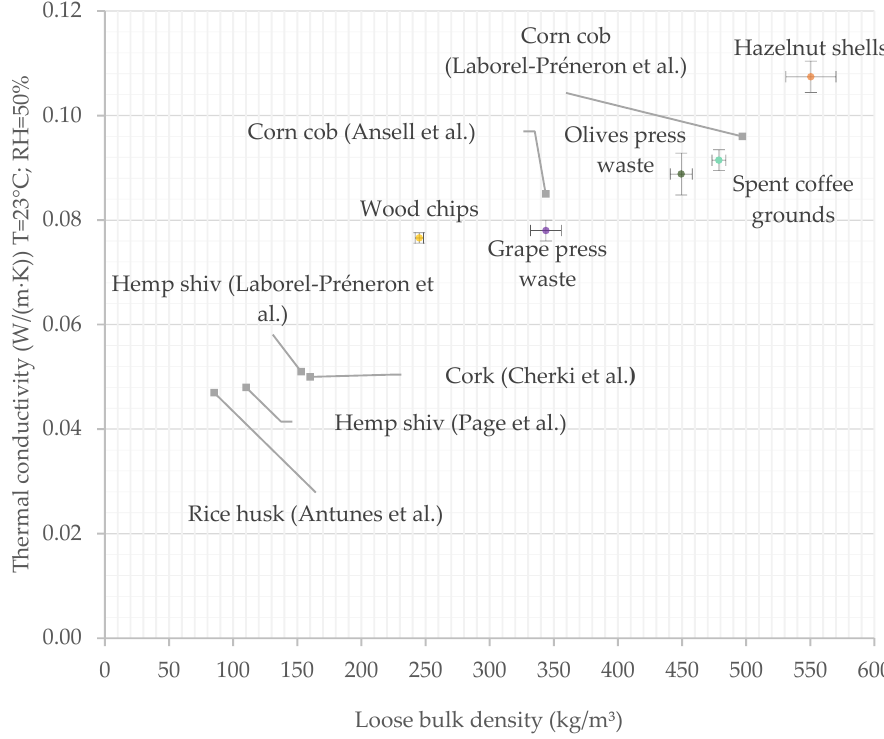
Figure 4. Correlation between thermal conductivity and RH of the tested bio-wastes.